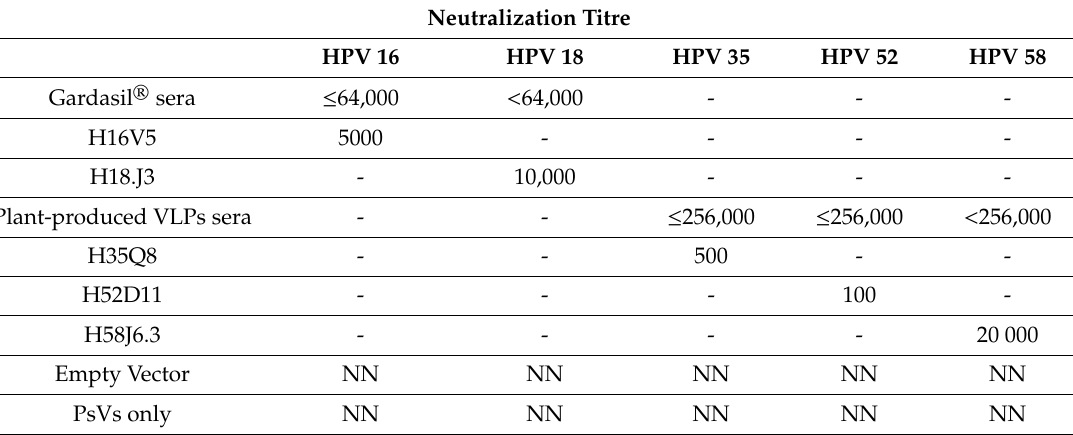
Plant-produced VLPs sera H35Q8